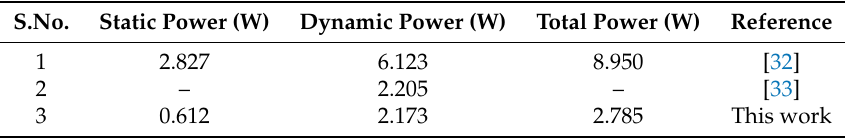
Table 2. Comparison of the power consumption with state-of-the-art